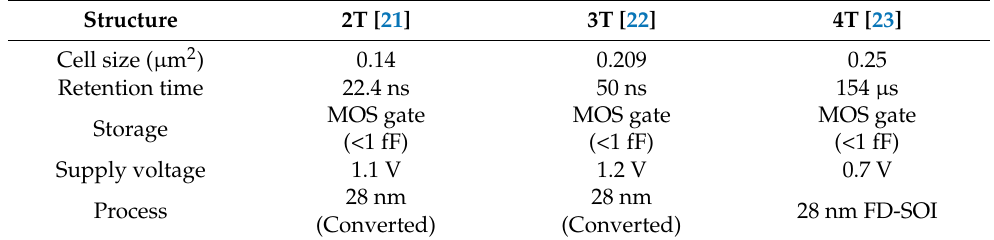
Table 1. Comparison of the retention times of eDRAM gain cells implemented in a 28 nm process.